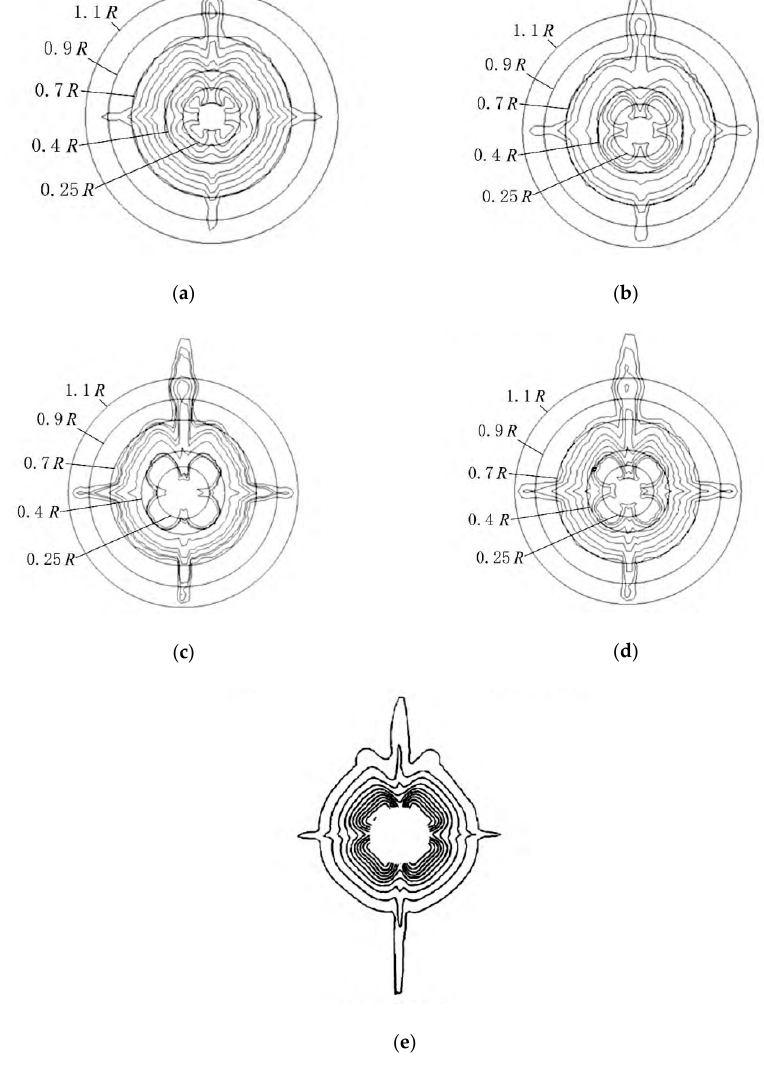
Figure 2. Comparison of the tail flow from the SUBOFF between the numerical calculation and experimental test. Numerical calculation: ( a ) y + < 50; ( b ) y + < 100; ( c ) y + < 250; and ( d ) y + < 300. ( e ) The experimental test.